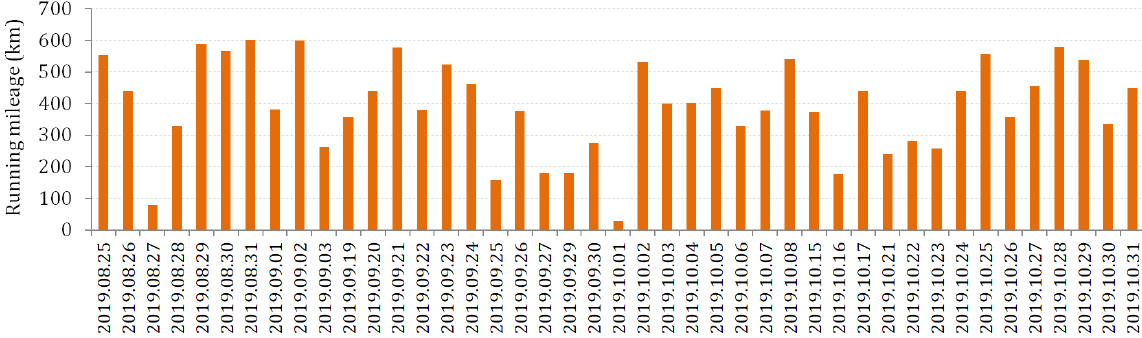
Figure 10. Daily mileage history in test period.